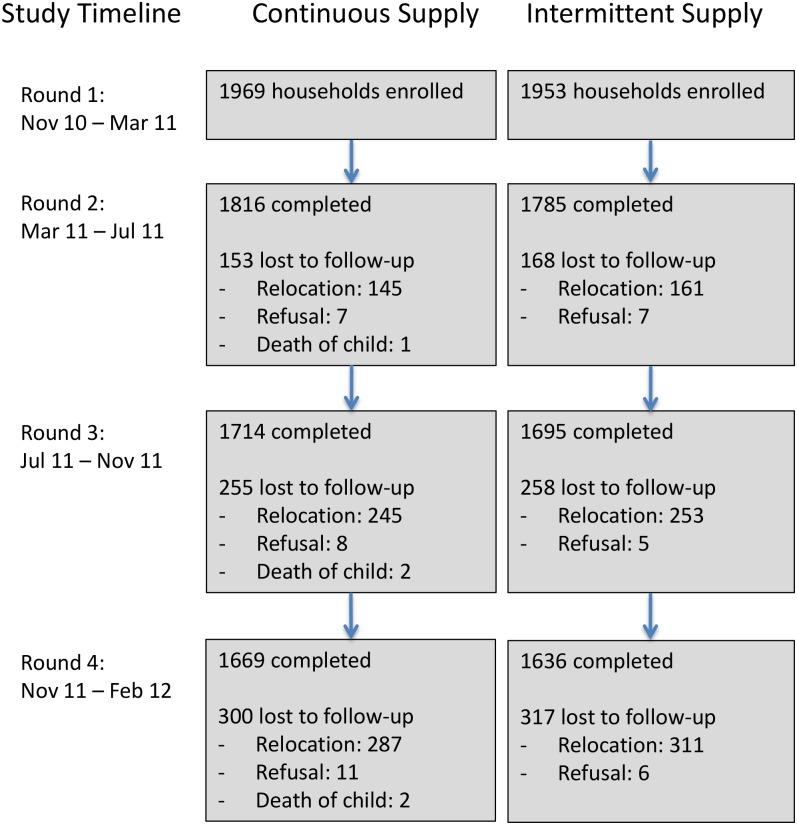
Number of households enrolled and lost to follow-up across study arms and data collection rounds.Of the 3,922 households we enrolled, 3,305 (84%) completed the study, while 617 households were lost to follow-up over the course of four rounds of data collection. The number of households lost to follow-up at each round was similar between the two study arms.